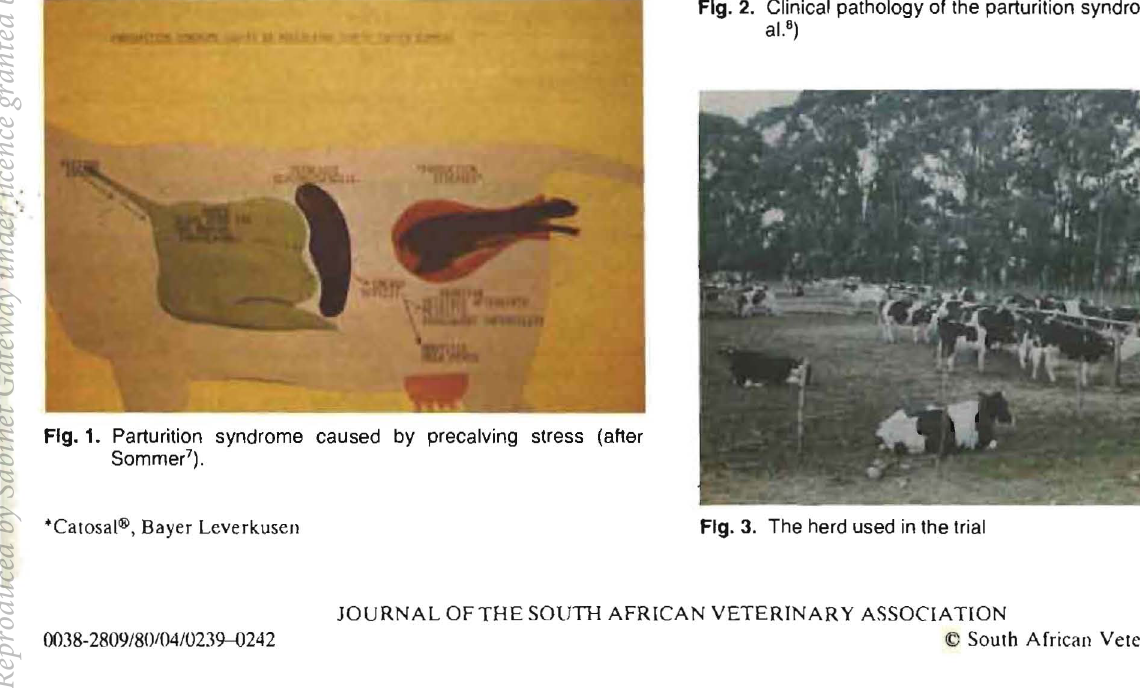
Fig. 2. Clinical pathology of the parturition syndrome (after Zepgi et a1. 8 )